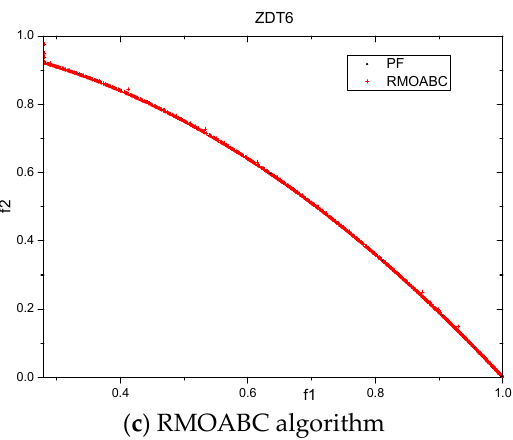
Figure 5. Plots of the non-dominated front found by the three algorithms for 2-objective ZDT6 test instance. ( a ) NSGA-II algorithm; ( b ) MOEA/D algorithm; ( c ) RMOABC algorithm.